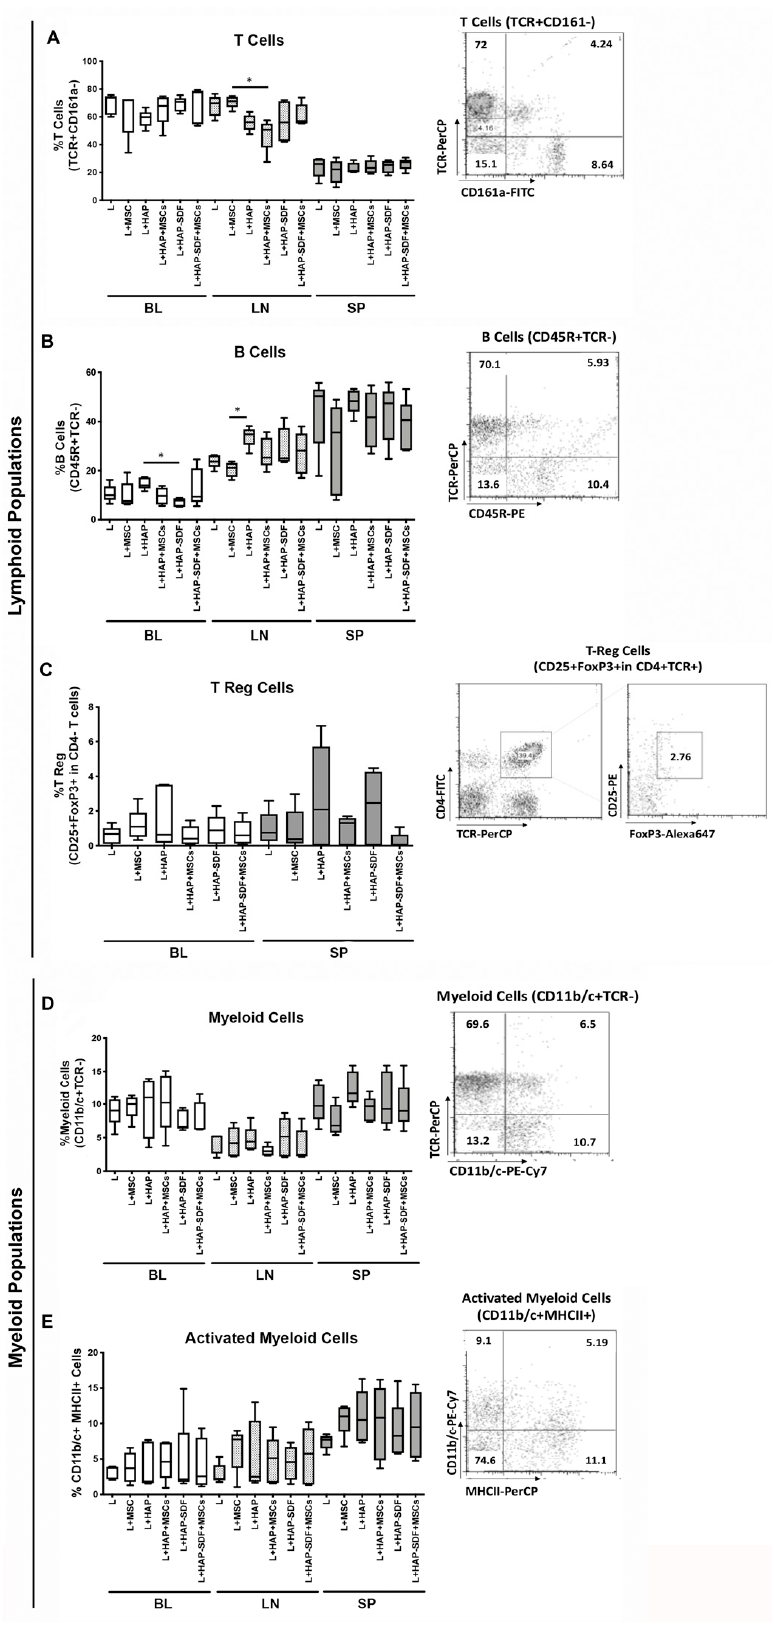
Figure 6. Systemic immune cell population profile. Phenotypic analysis of immune cell populations in peripheral organs: blood (BL), draining lymph nodes (LN), and spleen (SP), using flow